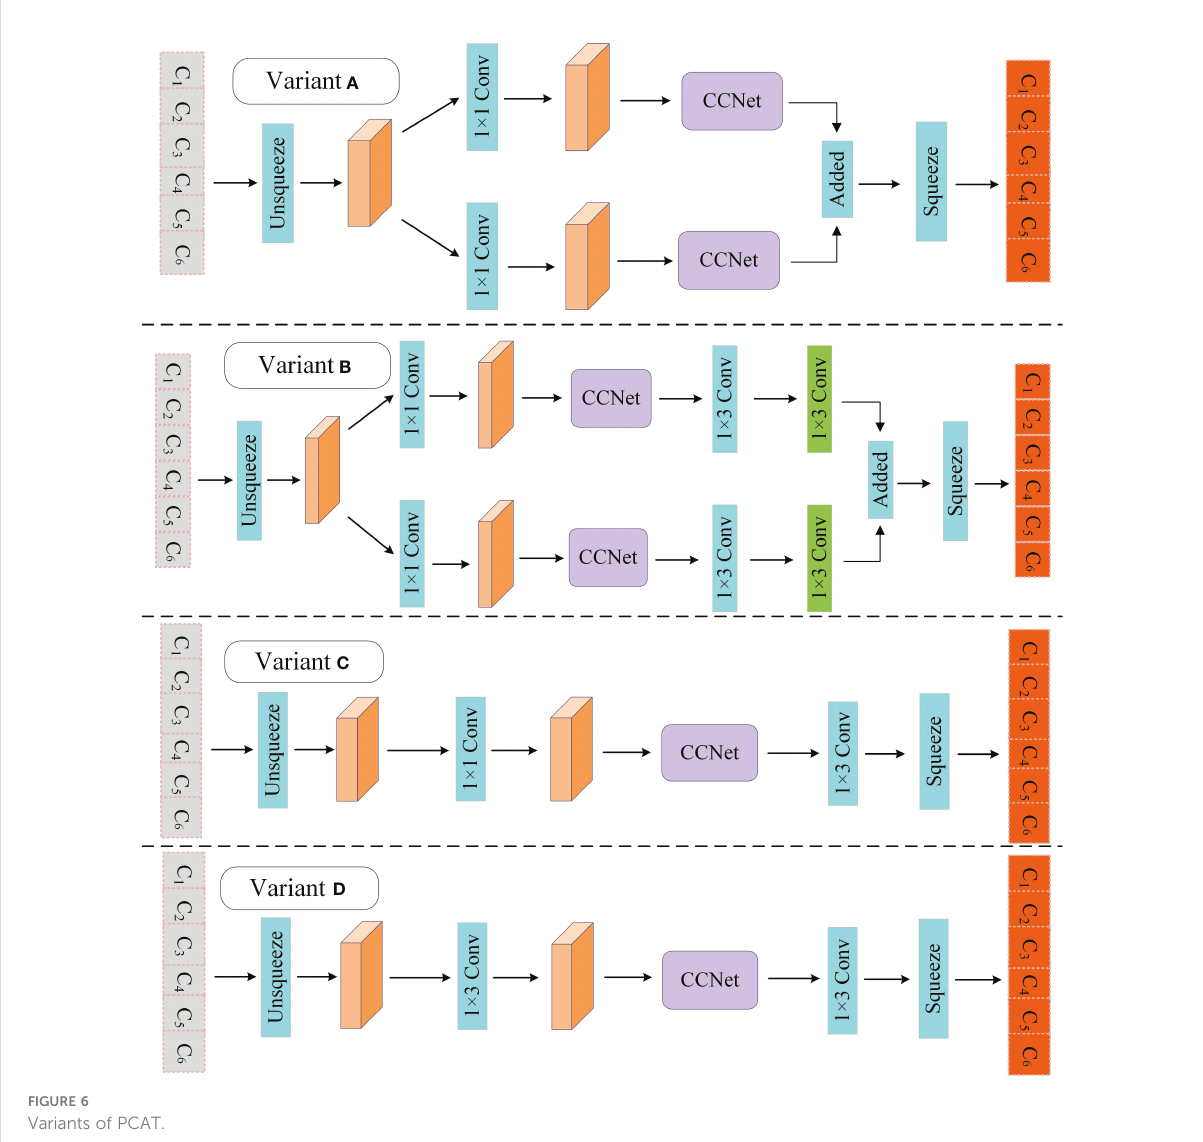
FIGURE 6 Variants of